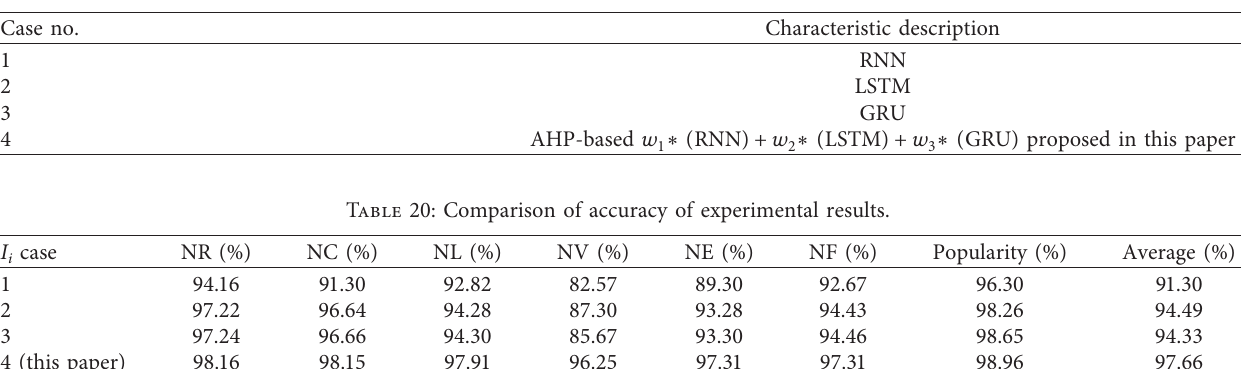
Table 19: Experimental cases.